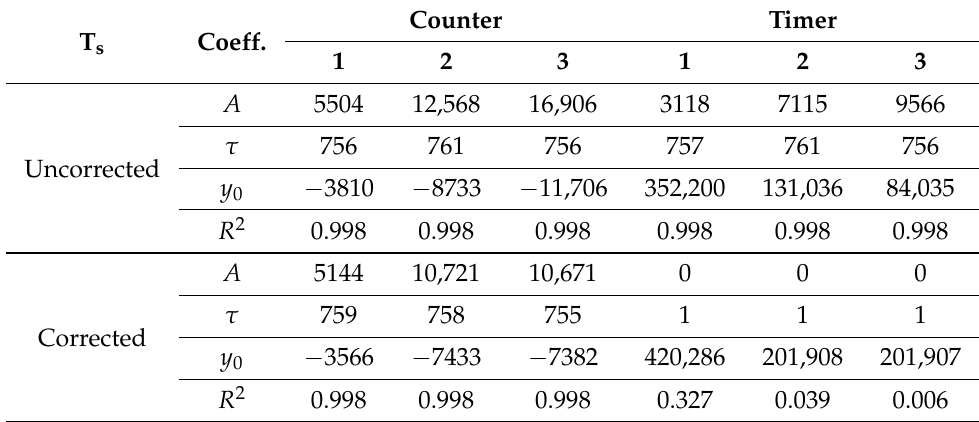
Table 3. List of model parameters for the data presented in Figure 4 for the uncorrected and corrected measurement sampling period (T s